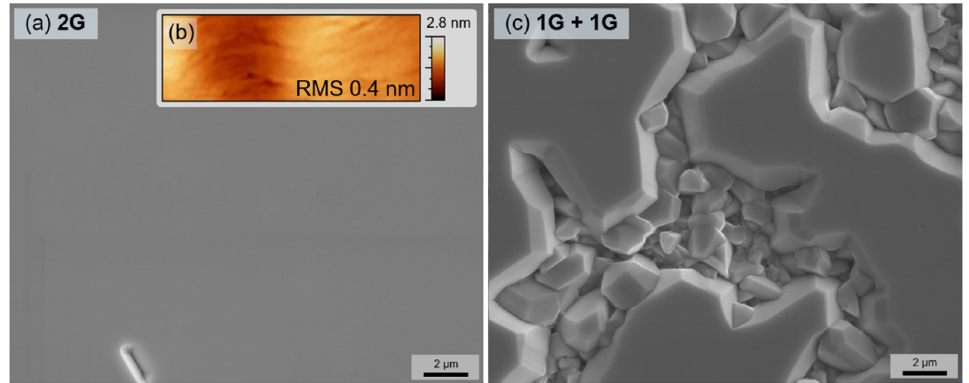
Figure 4. SEM images of the thick GaN epilayers grown on bilayer graphene ( a ) and double-stack of graphene ( c ). To assure that the image in ( a ) is in focus, an arbitrary defect is left visible. The surface morphology of GaN epilayer grown on bilayer graphene is represented by an AFM image within an area of approx. 2 µm × 5 µm ( b ).